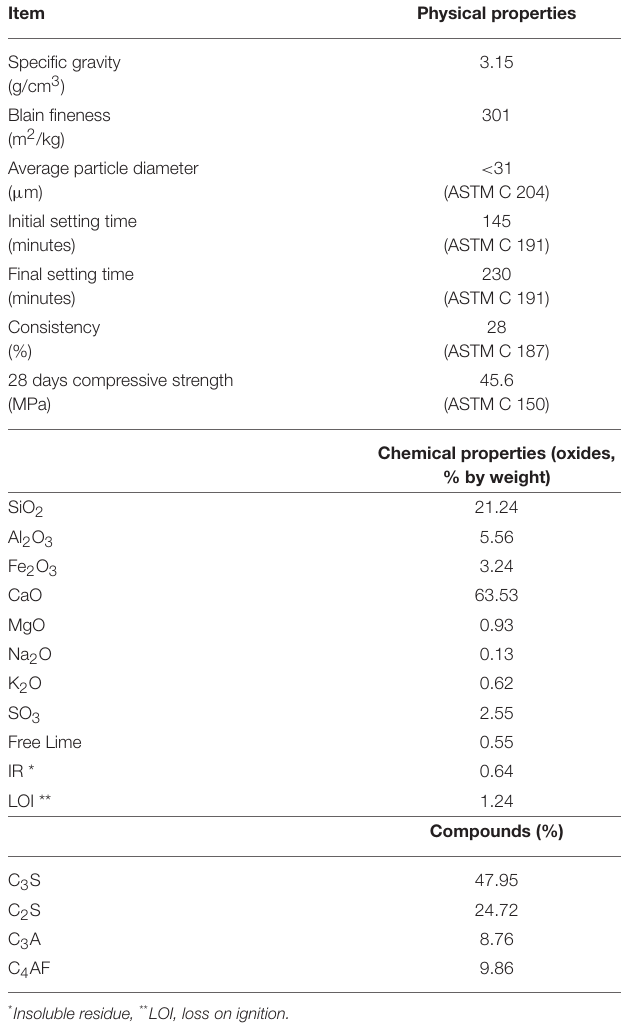
TABLE 1 | Physical and chemical analysis of Cherat